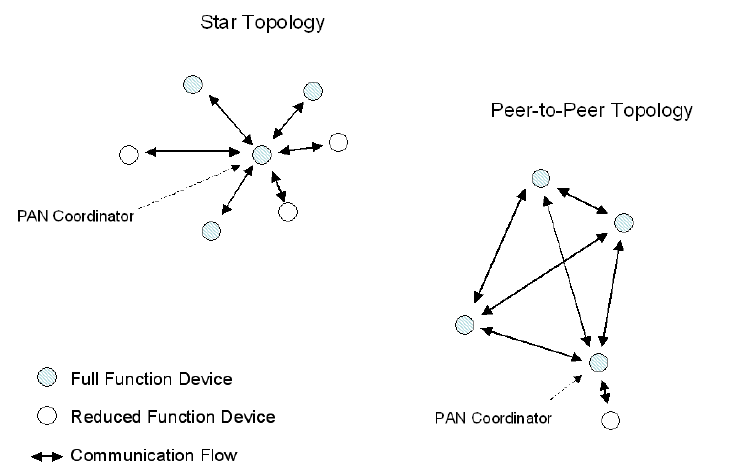
Figure 7. The two IEEE 802.15.4-compliant network topologies: star and peer-to-peer topology.